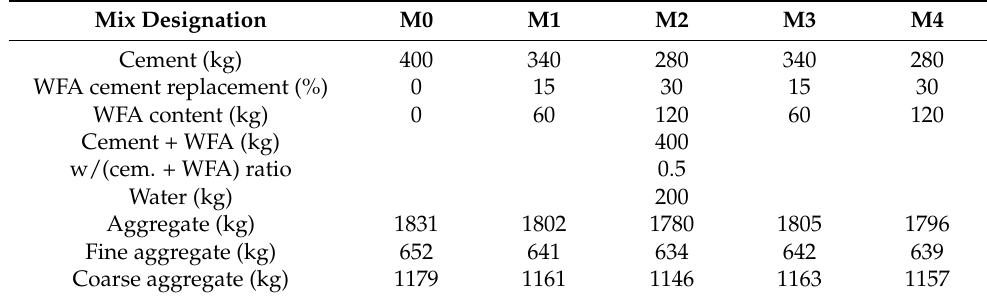
Table 2. Composition of the